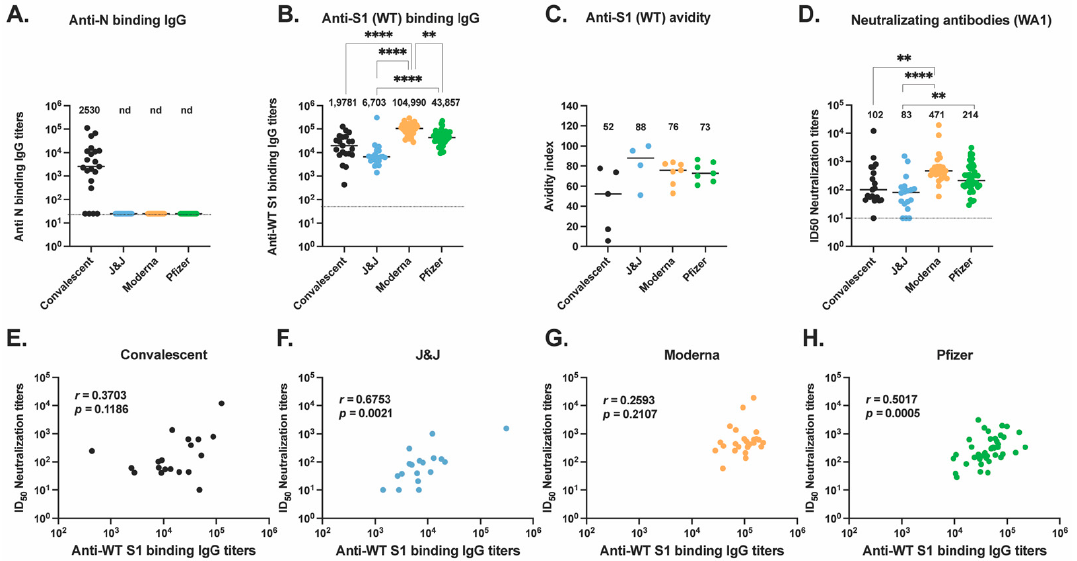
Figure 1. Antibody responses to ancestral SARS-CoV-2 elicited by vaccination or natural infection. ( A ) Anti-N IgG antibody titers ( B ) Anti-S1 IgG antibody titers were assessed for convalescent (black, n = 21), J&J (blue, n = 20), Moderna (orange, n = 28), and Pfizer (green, n = 47) participants. ( C ) Anti-S1 (WT) IgG antibody avidity assessed using urea wash ELISA. Data expressed as a ratio of urea-washed absorbance to unwashed absorbance for convalescent (black, n = 5), J&J (blue, n = 4), Moderna (orange, n = 7), and Pfizer (green, n = 7) participants. ( D ) Neutralizing antibody titers are shown as log 10 of half-maximal inhibitory dilution (ID50) for convalescent (black, n = 19), J&J (blue, n = 18), Moderna (orange, n = 25), and Pfizer (green, n = 43) participants. For plots A to C, ** p < 0.01, and **** p < 0.0001 by Kruskal–Wallis test. Dotted line shows limit of detection of the assays. Median is shown by black horizontal bar and values above each group, with data below the limit of detection, marked nd for non-detected. ( E – H ) Correlations between neutralizing antibody titers (ID50) and binding antibody titers for the ( E ) convalescent, ( F ) J&J, ( G ) Moderna, and ( H ) Pfizer groups. Spearman’s r and p values are